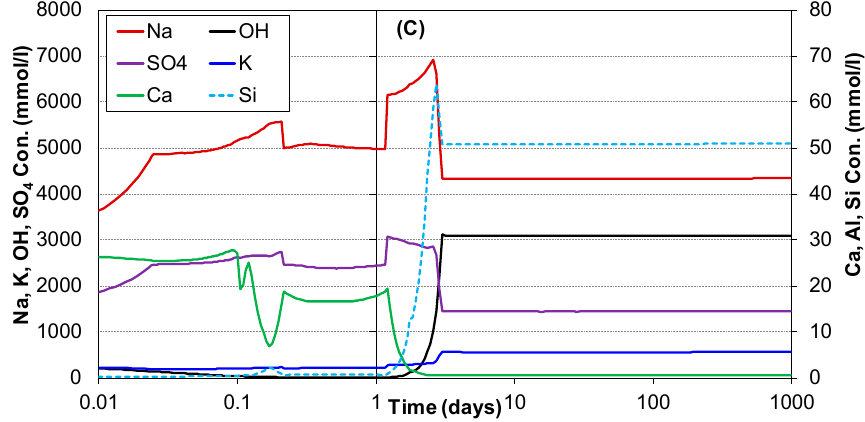
Figure 5. ( A ) Hydrate assemblage of PC without Na 2 SO 4 , ( B ) hydrate assemblage of PC with 25% of Na 2 SO 4 , and ( C ) pore solution concentration of PC with 25% of Na 2 SO 4 , for varying temperature.